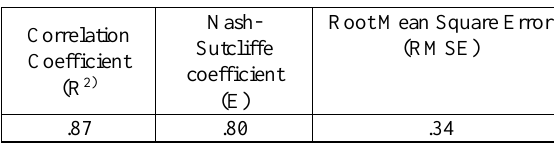
Table 6. Comparison of computed and observed